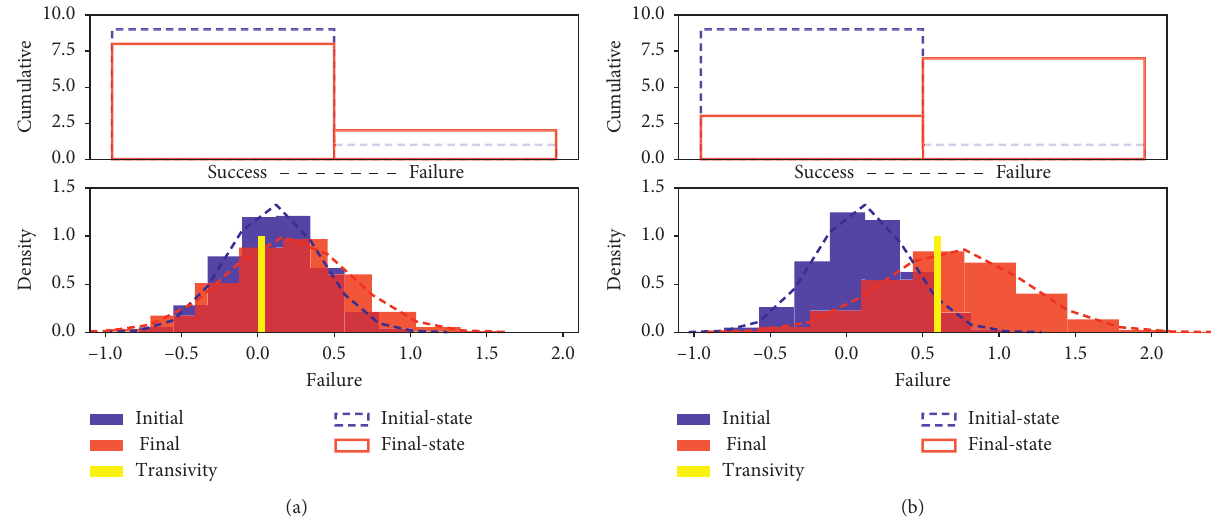
Figure 8: Schematic description of failure with distribution. (a) The upper left-hand side plot represents the cumulative number of absences of failure (success) nodes from the initial (blue bar) and final (red bar) cases, and (b) the upper right-hand side plot represents the increasing number of failure nodes from the initial and final cases. The lower plots represent the probability distribution between the initial failure (blue) and the final failure (red), with the likelihood as the transitivity (yellow bar). Note that the influences of these failures are computed as the frequencies of the failure nodes in their initial and final states, i.e., as relative frequencies [ f j � h j / N, h j � 􏽐 k � the frequency of the failure state ( j ), and the proportion (percentage) of occurrences of failure in the statistical ensemble corresponds to the relative